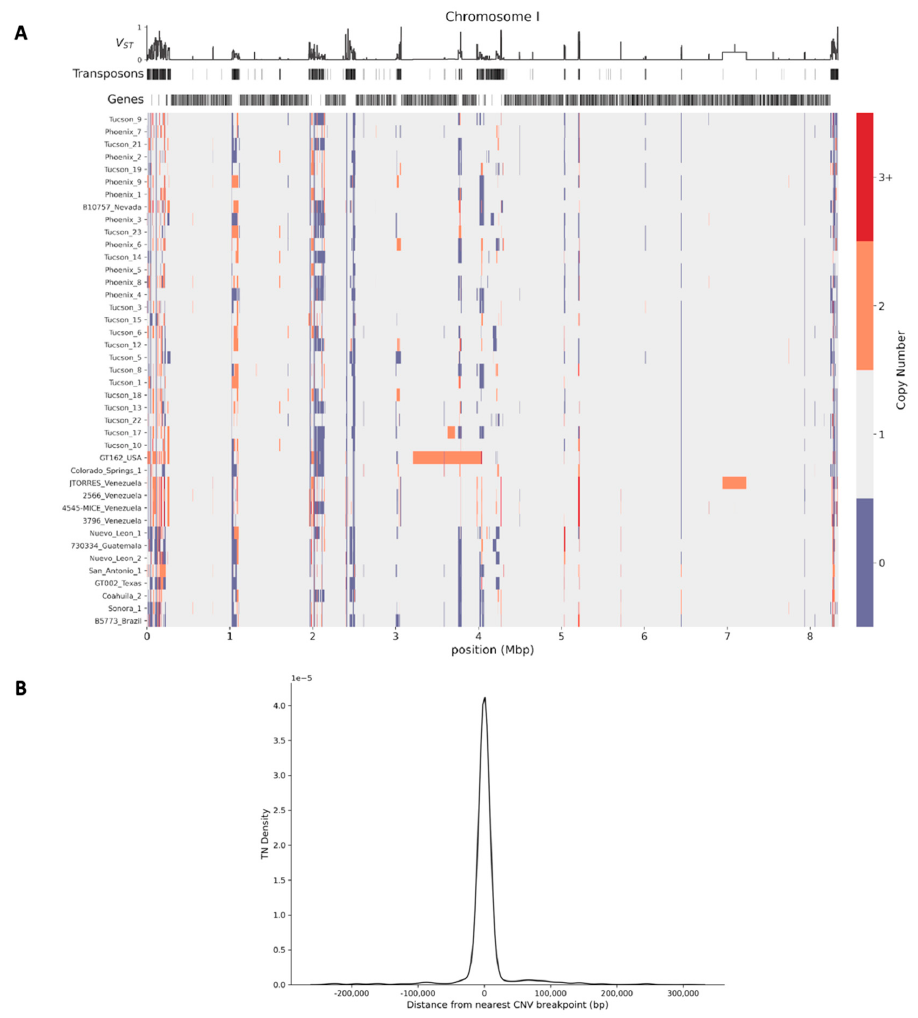
Figure 3. Copy number variants and their proximity to transposons across C. posadasii strains. ( A ) In the main panel, each row reports the results of quantification of copy number in the indicated strain relative to the C. posadasii reference assembly (Teixeira et al., 2021). The x-axis reports genome location, and the color scale reports copy number. At the top, the y-axis reports the V ST metric of population differentiation of the copy number; rows underneath report transposon and gene locations. Only results from chromosome I are shown; the remaining chromosomes are reported in Figure S2. ( B ) The x-axis reports the distance between a copy number variant (CNV) boundary and the nearest transposon; the y-axis reports the proportion of CNVs with the transposon distance on the x, as a kernel density estimate.